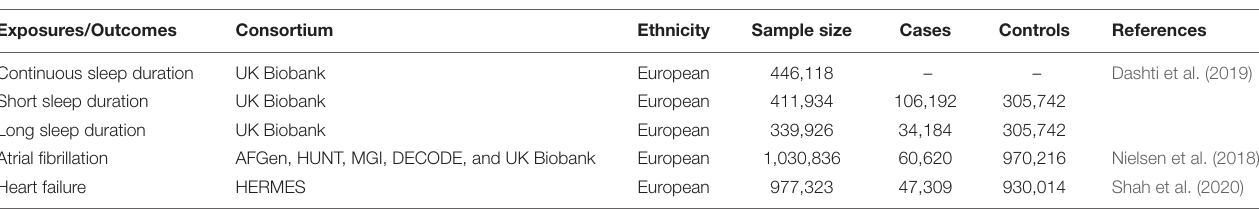
FIGURE 1 | Assumptions of a Mendelian randomization analysis. Three core assumptions: (1) genetic variants must be strongly associated with the exposure (sleep duration); (2) genetic variants should be independent of any other confounders; (3) genetic variants influence risk of the outcome (AF and HF) only through the exposure. TABLE 1 | Details of studies and datasets used for